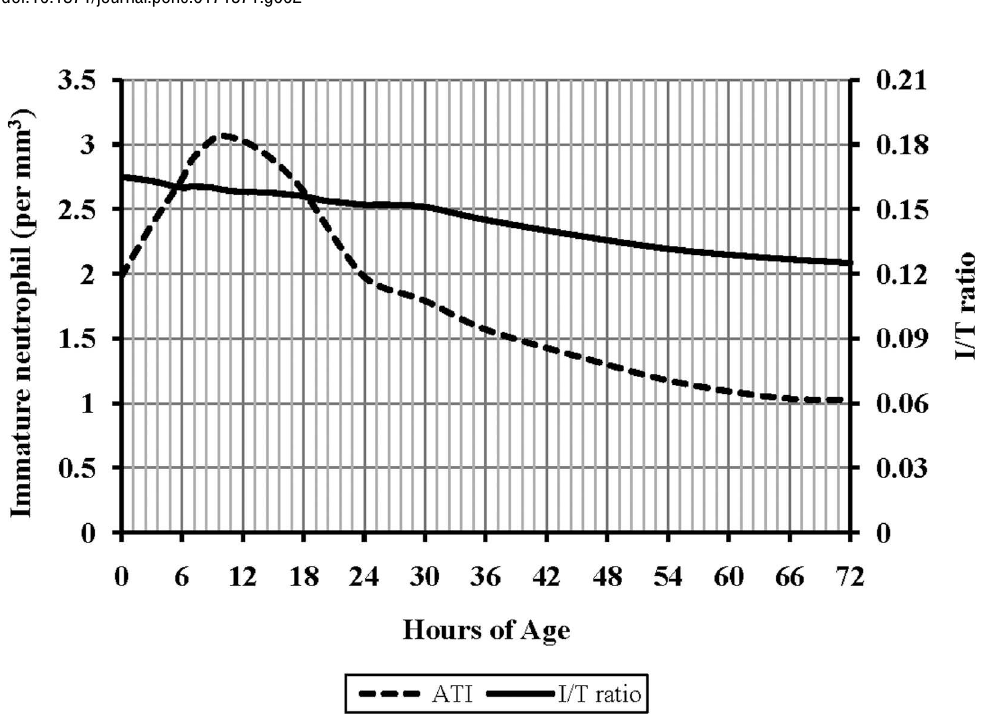
Fig 3. Referencerange for the absolute total immature neutrophils (ATI) and immature: total neutrophil proportion (I: T) during the first 72 h after birth of very low birth weight(VLBW) infants. A total of 1472 values were obtained for the analysis. The 95 th percentileis